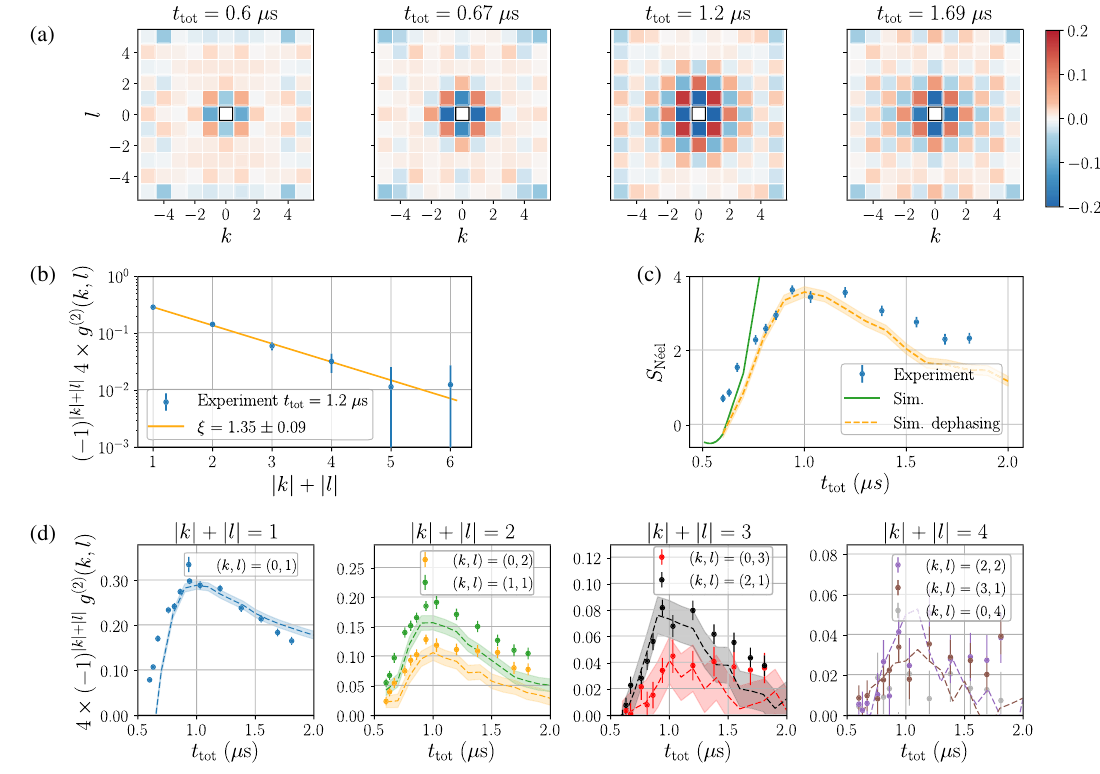
FIG. 3. Buildup and decay of correlations in a 2d square lattice antiferromagnet for different ramp durations t results for the 2d correlation function g ð 2 Þ ð k; l Þ for four different values of t sweep duration dependence. (b) The correlation function g ð 2 Þ (averaged within a Manhattan shell m ¼ j k j þ j l j ) decays exponentially with the Manhattan distance m , with a correlation length ξ of about 1.4 lattice sites. (c) N´eel structure factor S The green solid line shows the result of a numerical simulation using exact diagonalization for a 4 × 4 system without dephasing, while the yellow dashed line denotes a numerical simulation including dephasing (see Appendix C). (d) Dependence of the correlations on t for nearest, second-nearest, third-nearest, and fourth-nearest neighbors. One observes a dependence not only on the Manhattan distance j k j þ j l j , but also on k − l (see Sec. V C). The dashed lines represent a numerical simulation including dephasing (the shaded area corresponds to the s.e.m. obtained